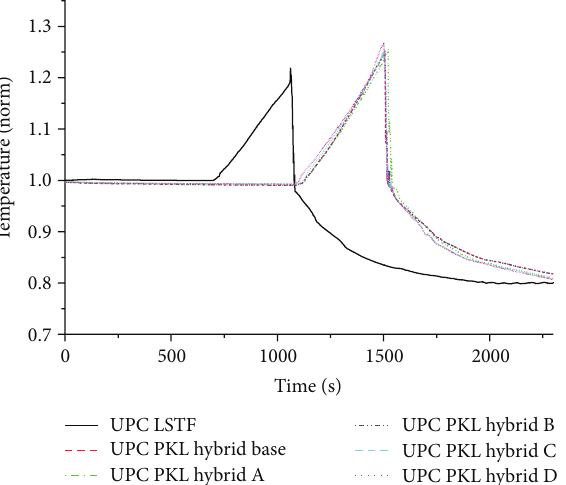
Figure 12: Core exite